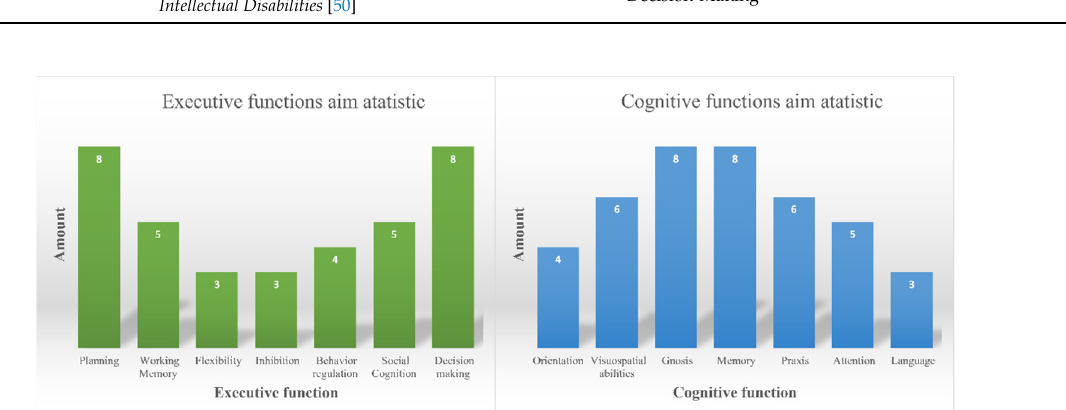
Figure 2. Statistics on the focus of research in relation to the main executive and cognitive functions.